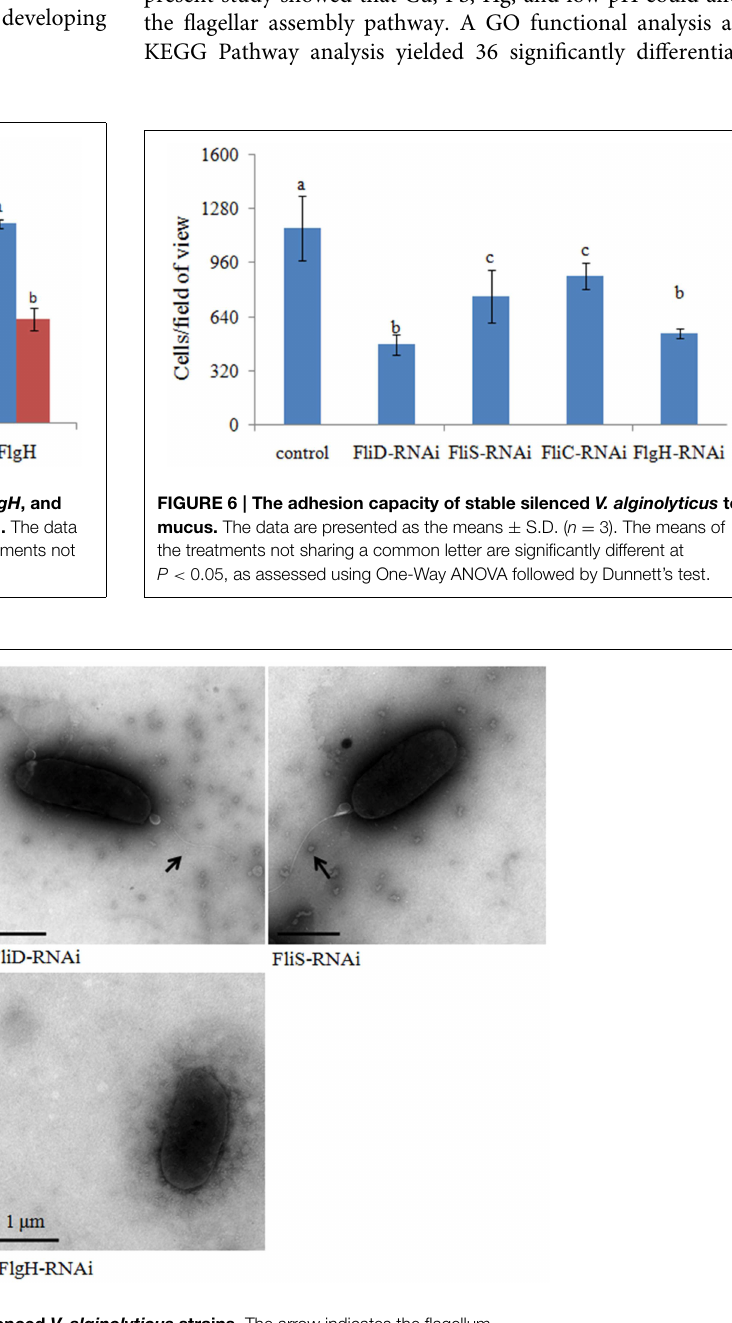
Frontiers in Cellular and Infection Microbiology |